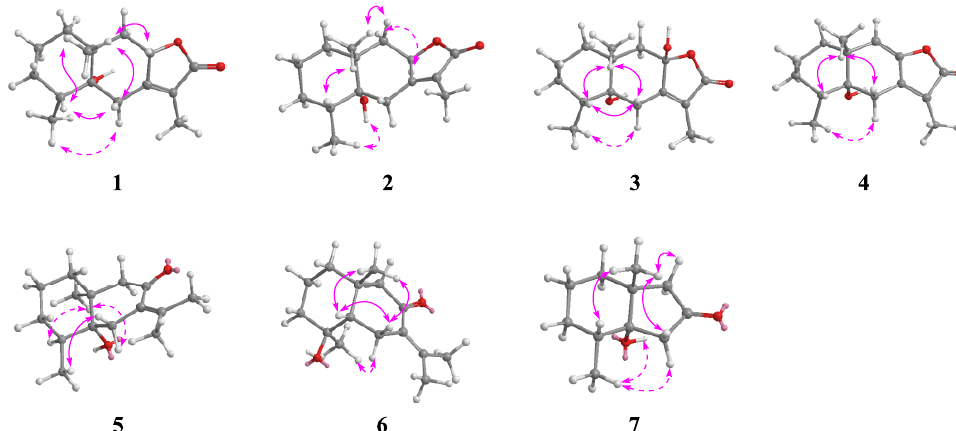
Figure 3. Key ROESY correlations ( ↔ ) of compounds 1 – 7 .